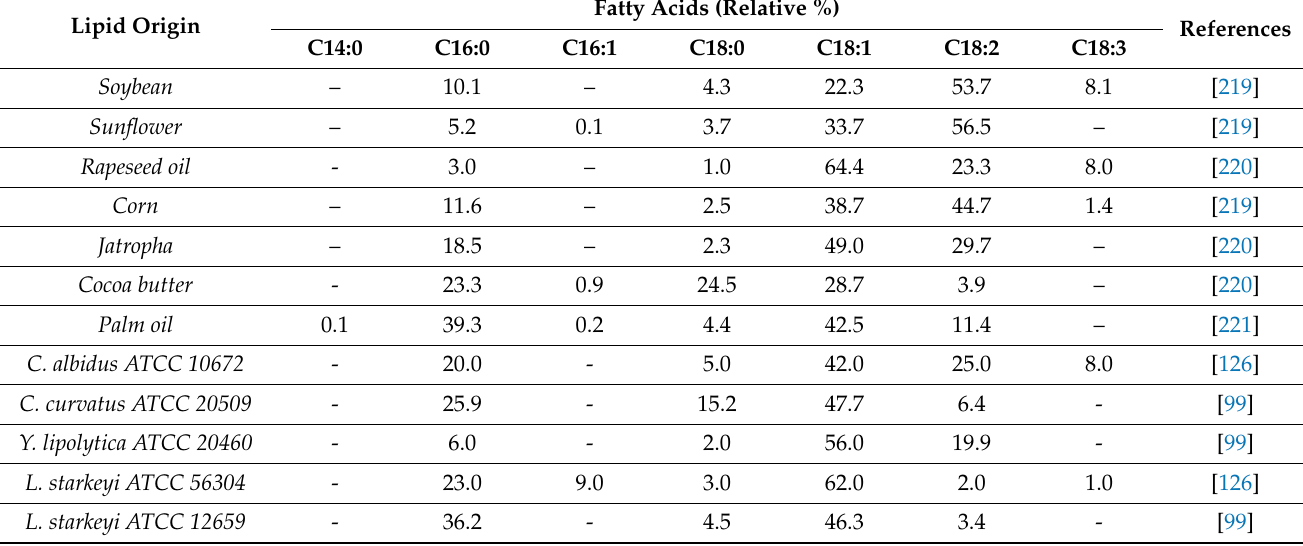
Table 6. Comparison of composition in the main fatty acids of lipids from vegetable species and oleaginous yeasts. Lipid